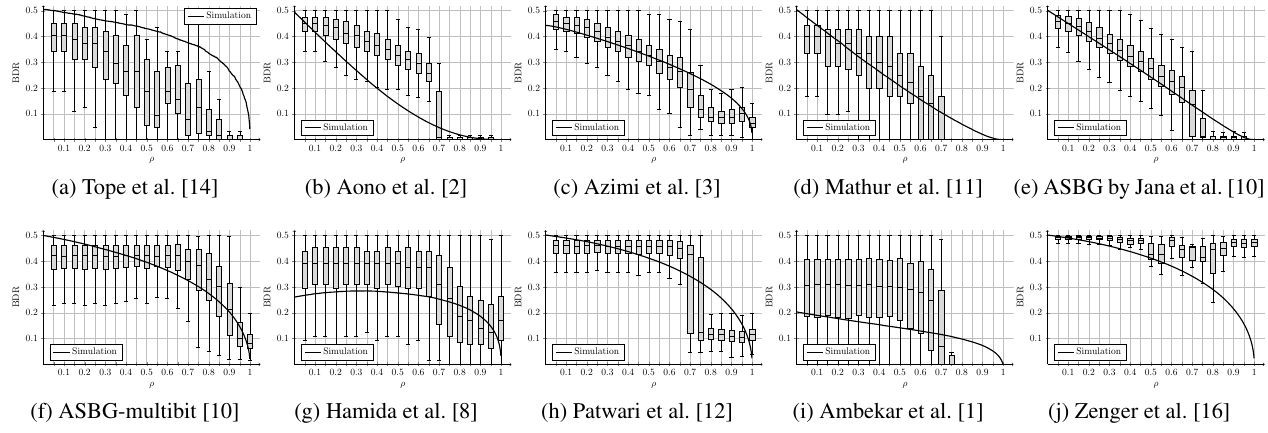
Figure 7: Evaluation results based on real-world measurements for different quantization schemes. The bit disagreement rate versus correlation coefficient ρ is